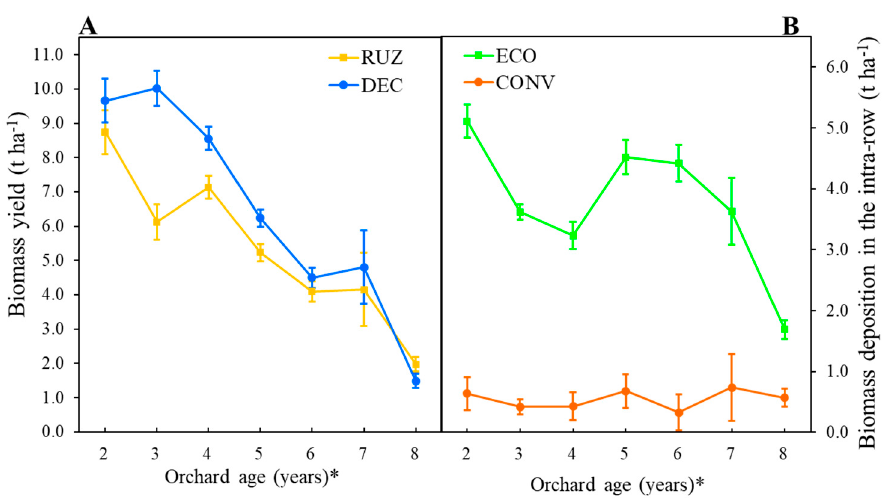
Figure 2. Yield ( A ) and deposition ( B ) of biomass from Urochloa spp. in the intra-rows, tested with di ff erent cover crops, mowers, and the use of glyphosate. The figures represent the sum of three mowings per growing season (Mogi Mirim, S ã o Paulo, 2012–2019). Legend: RUZ = Urochloa ruziziensis , DEC = U. decumbens , ECO = ecological mower, CONV = conventional mower. The significant di ff erence was accounted for by the Tukey test ( p < 0.05), and the error bars represent the minimal significant di ff erence. * Orchard age: 2012–2013 (2), 2013–2014 (3), 2014–2015 (4), 2015–2016 (5) 2016–2017